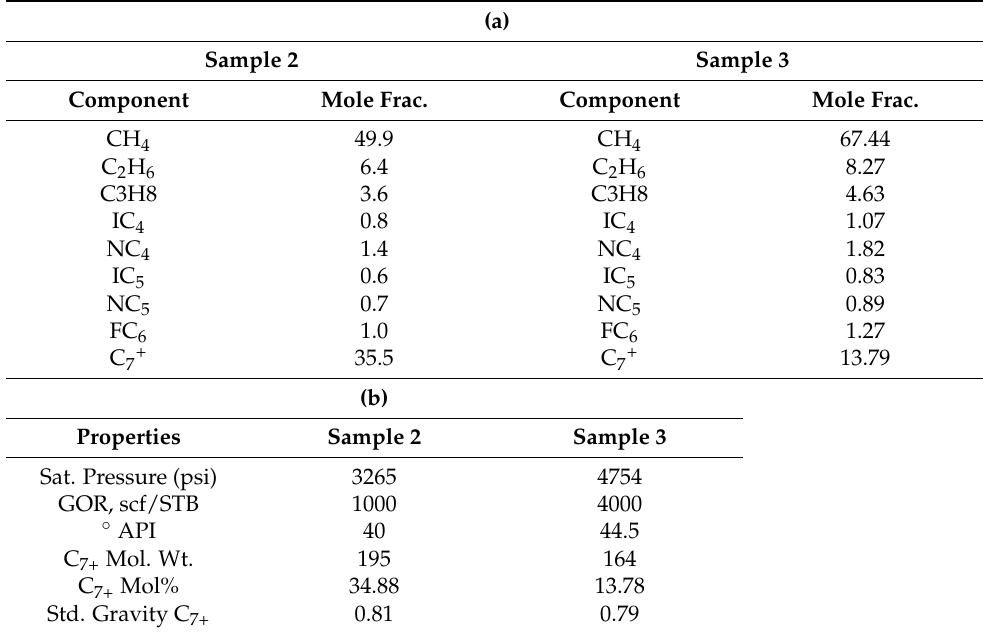
Table 3. Properties of Sample 2 and Sample 3 fluid ((a): composition; (b): tuning parameters).